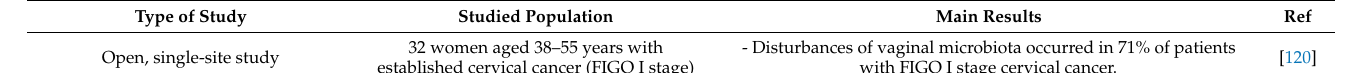
Table 1. Results of studies demonstrating the impact of dysbiosis and HPV infection on cervical cancer